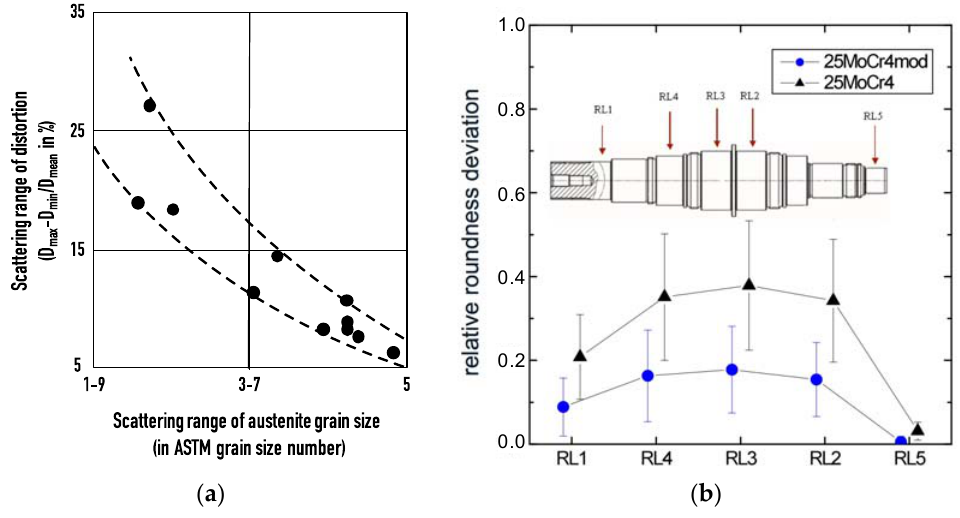
Figure 11. Reducing quench distortion in carburizing steel: ( a ) influence of mean prior austenite grain size scattering in steel 16MnCr5 (1.7131) on quench distortion [22]; ( b ) roundness deviation of a heat-treated transmission shaft measured at five positions for standard 25MoCr4 (1.7325) and 25MoCr4 modified by Nb ‐ microalloying.